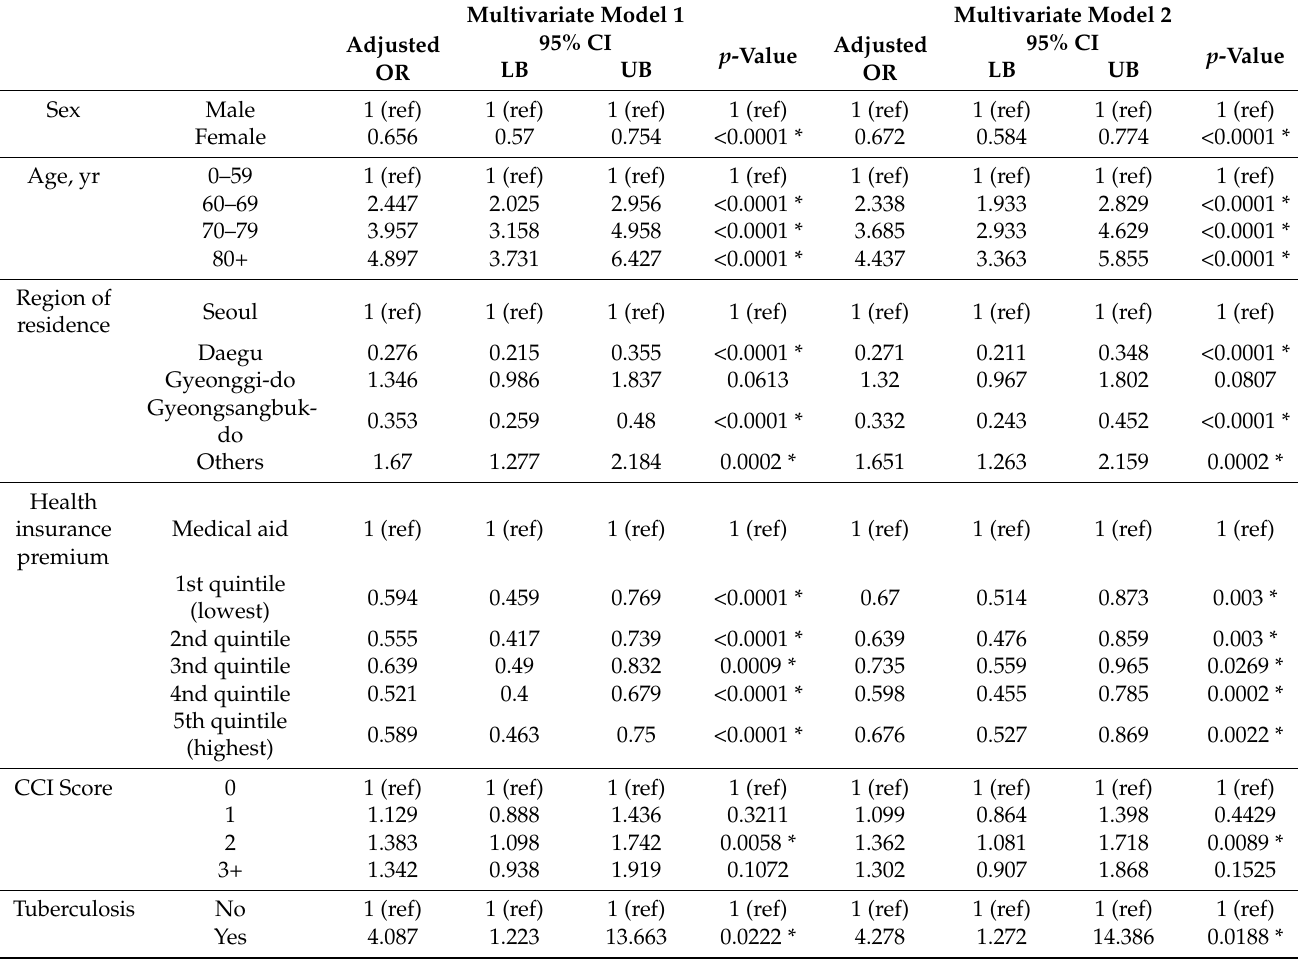
Table 3. Odds ratio for the risk of ICU admission.